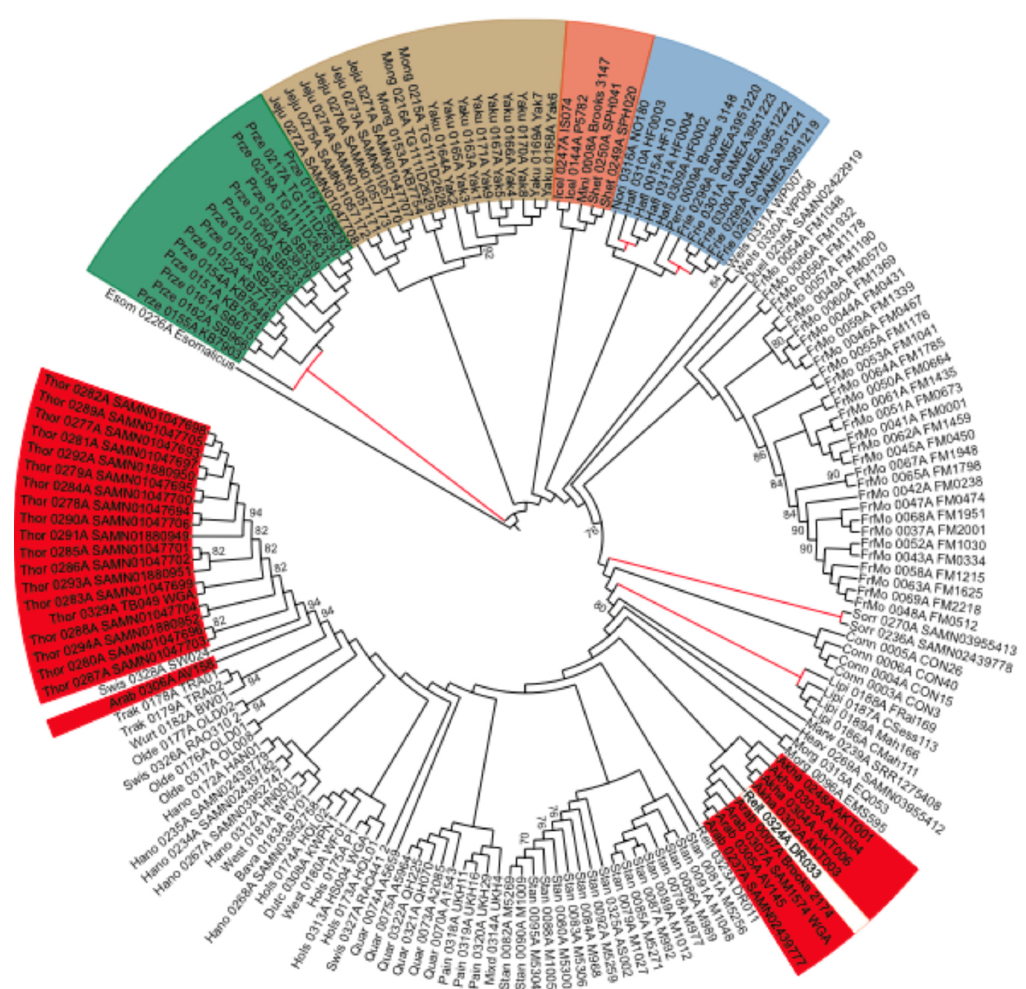
Figure 2. Neighbor-joining (NJ) cladogram depicting the horse phylogenetic relationships, mid-point rooted using the donkey as the outgroup. Color ranges highlight monophyletic lineages, including Przewalski horses (green), Mongolian-derived (brown) and Nordic (orange) breeds, as well as coldblooded (blue) and hotblooded (red) lines. Most of the non-colored taxa correspond to admixed warmblood lines, whose phylogenetic placement depends on the relative contribution of other influential breeds. Long internal branches are highlighted in red, as possibly reflecting episodes of elevated drift. Only bootstrap support values lower than 95% are displayed to avoid overloading the